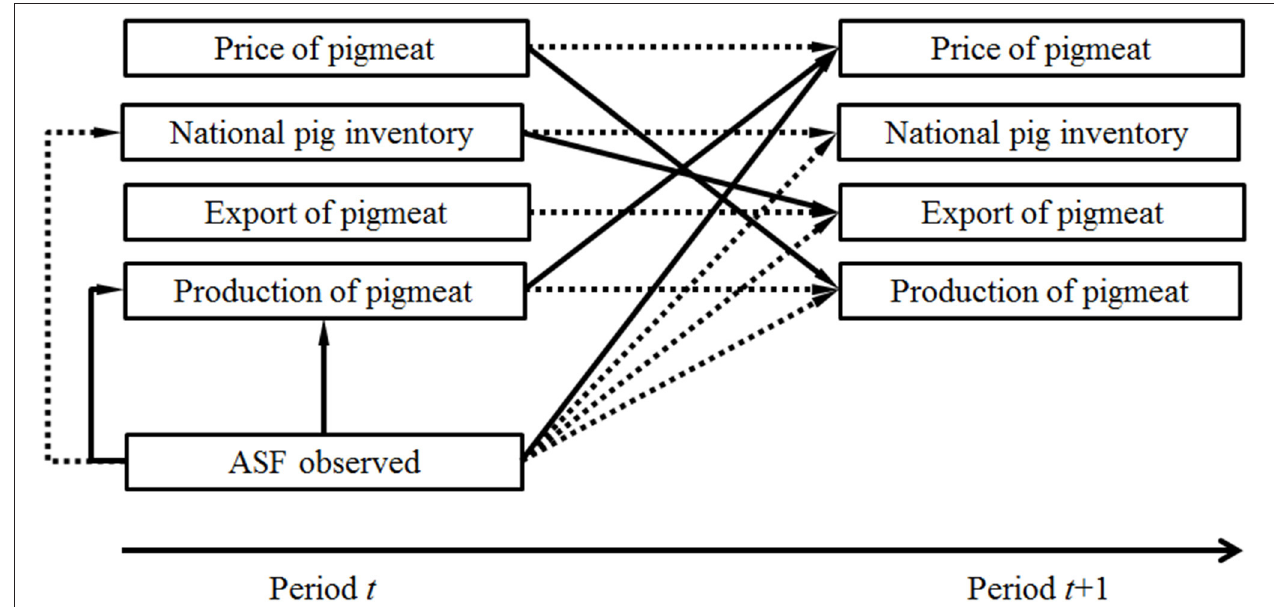
FIGURE 3 | An illustration of the main effects of variables (presented in boxes) according to the estimated system of equations in two time periods [ t (on the left) and t + 1 (on the right)]. Dashed lines represent a negative association (an increase in one variable is associated with a decrease in another variable) and solid lines represent a positive association (an increase in one variable is associated with an increase in another variable). Observed cases of ASF in domestic pigs or wild boar are associated with variables in four uppermost boxes in the present period t . These all may be associated with variables on the right-hand in the next period ( t +